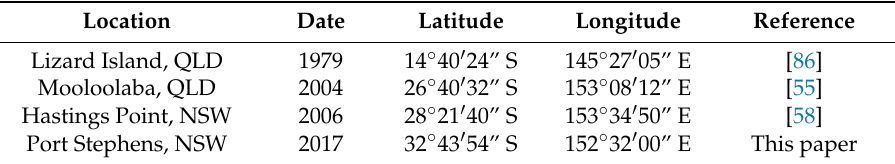
Table 10. Eastern Australian distribution records of Phestilla